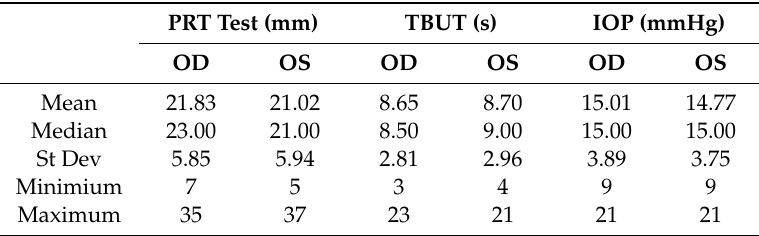
Table 1. Descriptive results for all the outcome measures.